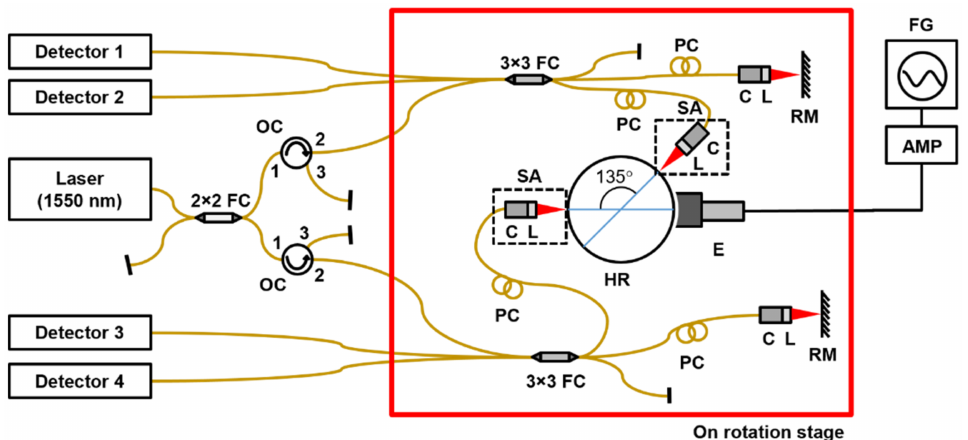
Figure 6. The HRG system implemented with 3 × 3 optical interferometers. The system operates in the non-feedback open-loop (NFOL) mode. RM: reference mirror, SA: sample arm, PC: polarization controller, HR: hemispherical resonator, E: electrode, FC: fiber coupler, OC: optical circulator, FG: function generator, AMP: amplifier, C: collimator, L: